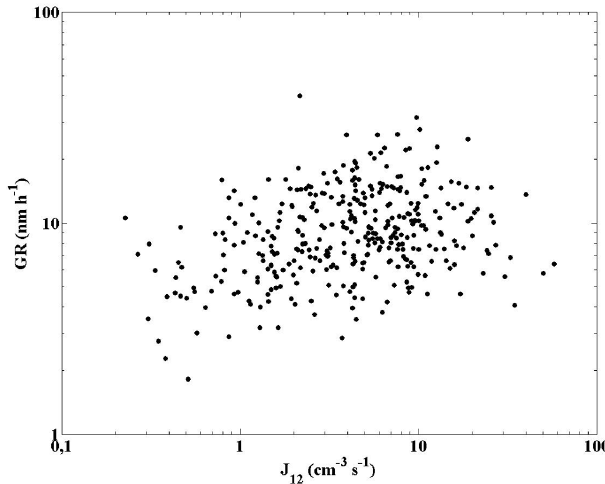
Fig. 11. Formation rate of 12nm particles as a function of growth rate (12–30nm) based on the DMPS data.